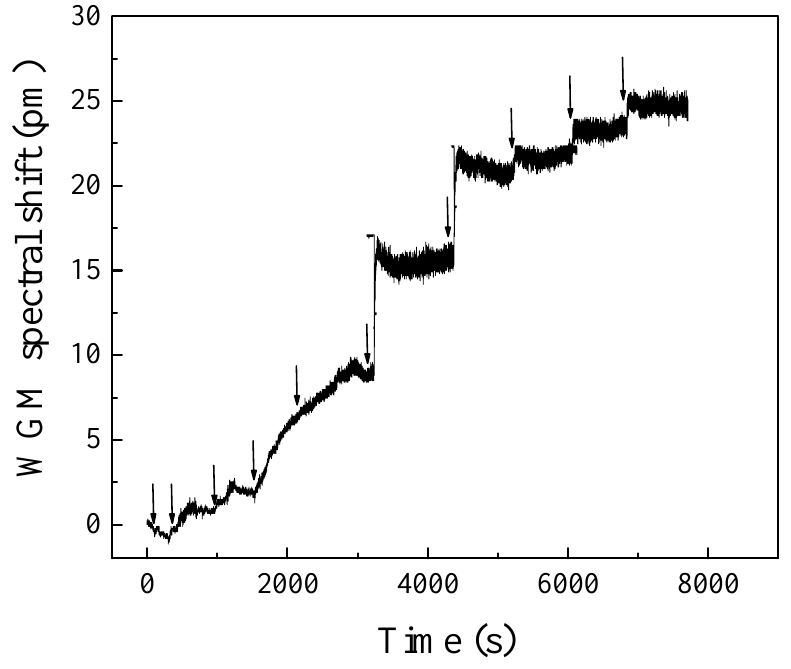
Figure 6. Sensorgram of thrombin binding to sphere surface immobilized with aptamers. Arrows indicate when thrombin is added. The final concentrations of thrombin are 5 NIH/mL, 14.2 NIH/mL, 34 NIH/mL, 75 NIH/mL, 188 NIH/mL, 256 NIH/mL, 320 NIH/mL, 378.6 NIH/mL, 434 NIH/mL, respectively, after each injection. Sphere size R=150 µ